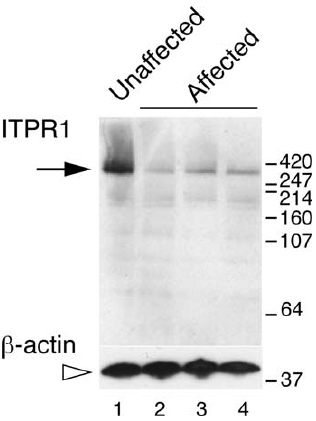
Figure 4. Western Blot Analysis of ITPR1 Protein Levels in EBV Immortalized Lymphoblasts from AUS1 Family Members Western blot performed to examine ITPR1 levels in EBV immortalized lymphocytes from AUS1 affected family members carrying the ITPR1 deletion and from an AUS1 family member of unknown disease status who does not carry the deletion. Notably the samples from patients with ITPR1 deletion show a dramatic decrease in ITPR1 levels. To demonstrate equal loading, these samples were diluted one in five, and the Western blot was repeated using an antibody against ACTB.